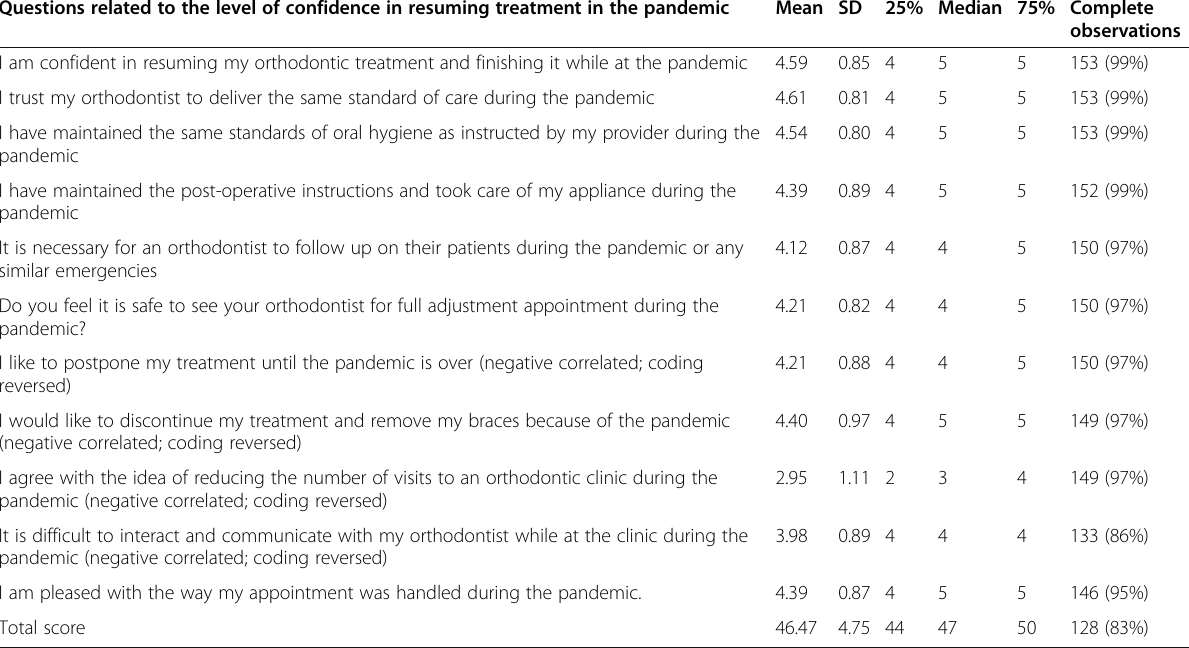
Table 7 A descriptive summary for the 11 questions related to the confidence in resuming orthodontic treatment Questions related to the level of confidence in resuming treatment in the pandemic